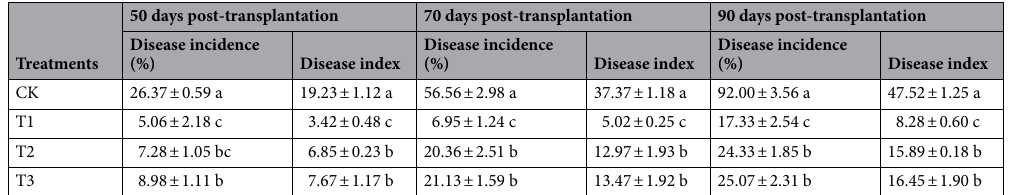
Table 1. The occurrence of tobacco bacterial wilt of four treatments. All data are presented as the mean ± SE. CK: the control group, T1: marigold powder mix with B. amyloliquefaciens ZM9 group, T2: B. amyloliquefaciens ZM9 group, T3: marigold powder. The different letters in the same column indicate significant differences at p < 0.05 according to LSD test.